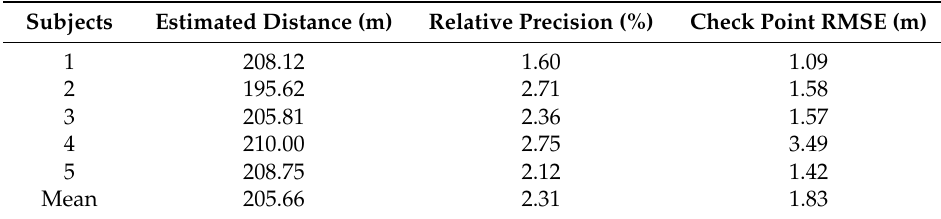
Figure 12. The experimental trajectories of the proposed PNS. Subfigure ( A ) shows the experimental route and check points; Subfigures ( B ), ( C ), ( D ), ( E ) and ( F ) are the results of five participants, respectively. The blue circle is the start location, and the green dotted line represents the solution with the usage of heading information from the gyroscope. The red box is the position updated by beacon. The numbers indicate the different classrooms. Table 5. The results of relative precision for all subjects.